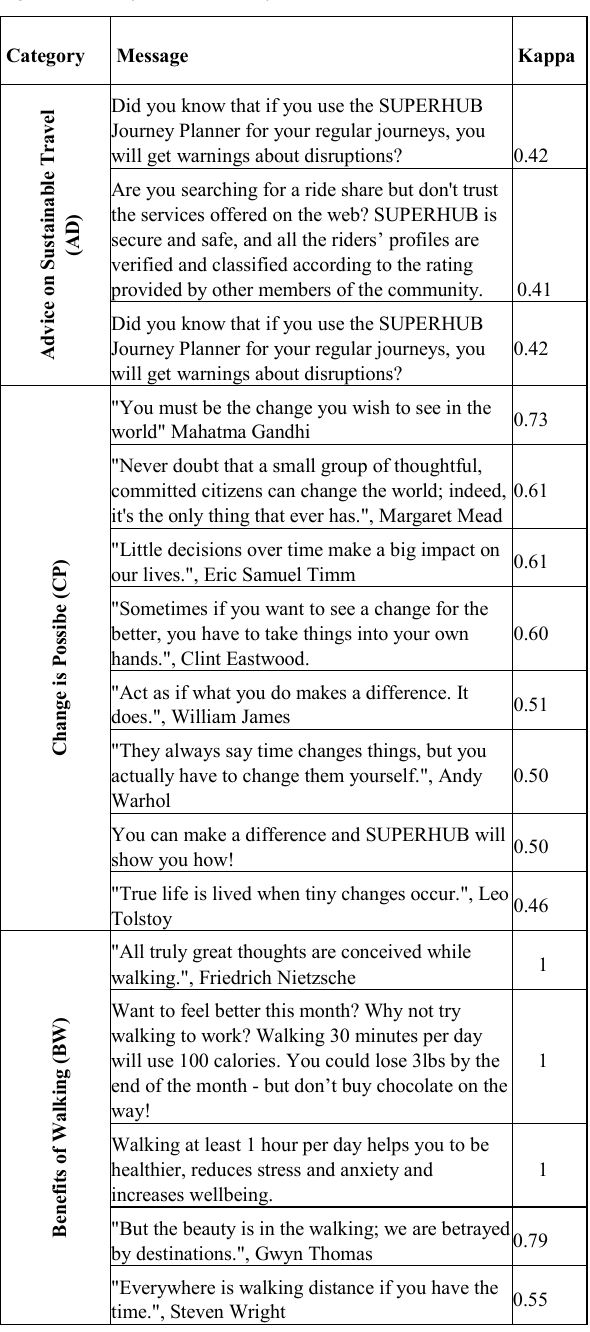
Table 3. Messages with adequate inter participant agreement (kappa ≥